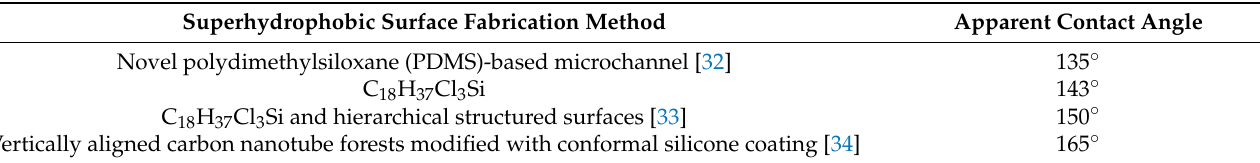
Table 1. Apparent contact angle in different superhydrophobic surface fabrication